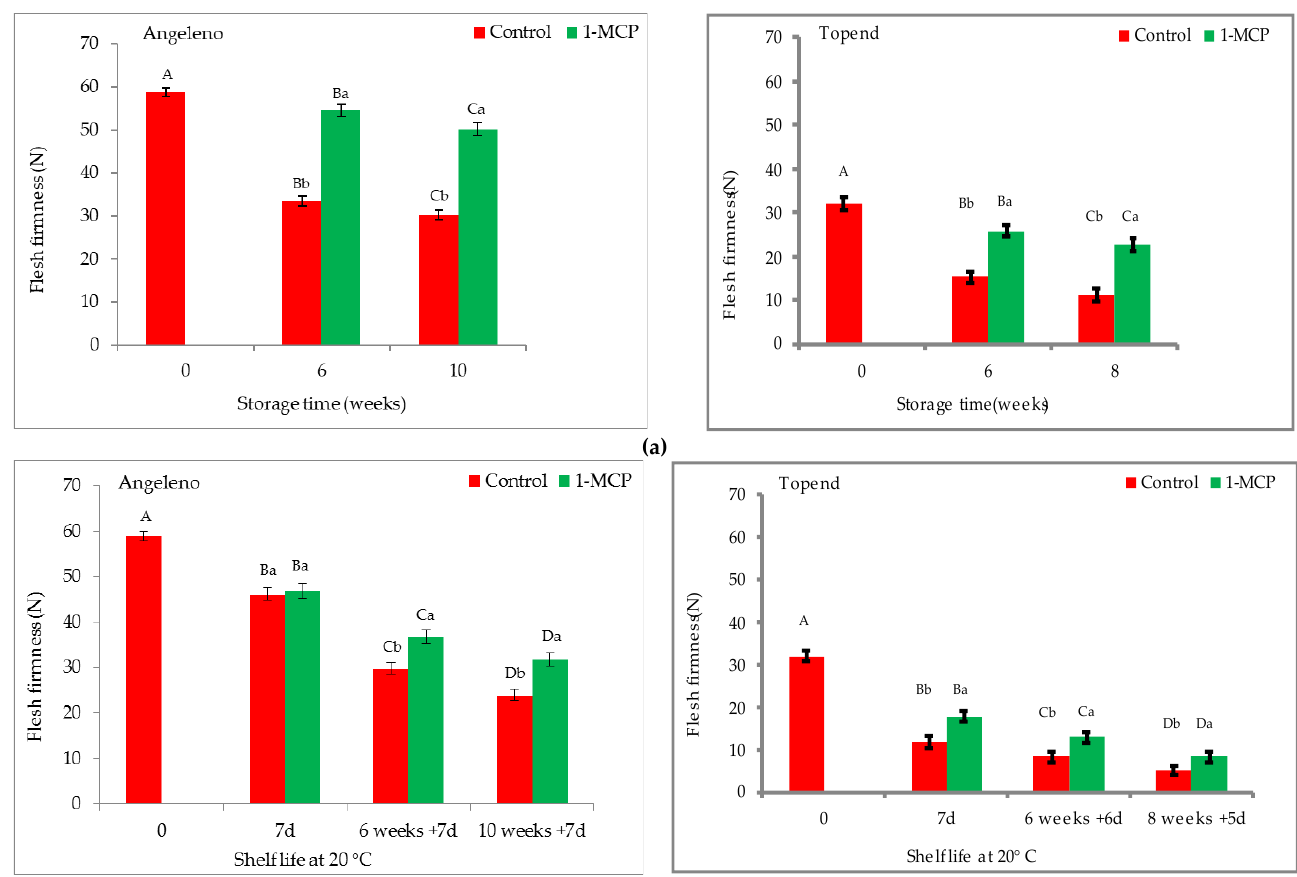
Figure 4. Flesh firmness of plum during cold storage at 1 °C ( a ) and subsequent shelf-life storage at 20 °C ( b ). Presented values are mean ± SD. Upper case is for the comparisons of time (Tukey’s, p < 0.05). Lower case is for the comparisons of treatment (Tukey’s, p < 0.05).